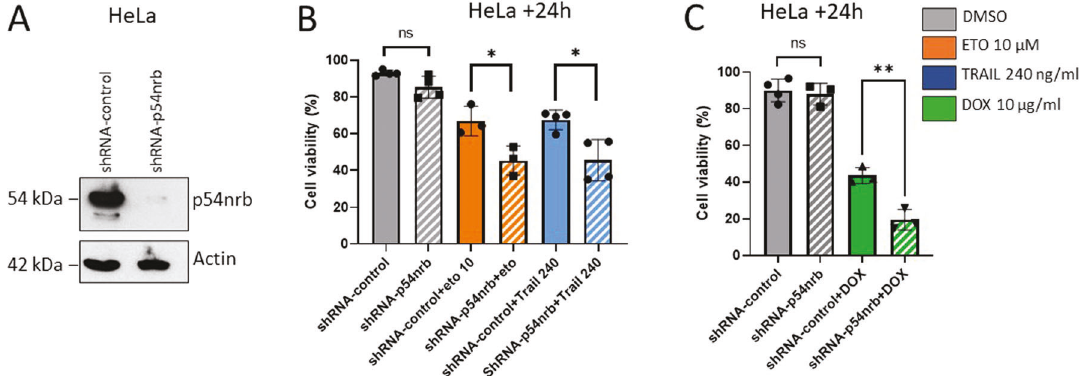
Fig. 2 Depletion of p54nrb leads to increased cell death susceptibility. A Immunoblot of p54nrb-level in shRNA-control and shRNA- p54nrb#3 knock down HeLa cells. B Flow cytometry of HeLa shRNA-control and shRNA-p54nrb#3 cells at 24 h after treatment with 10 µM etoposide (Eto) and 240 ng/ml human recombinant TRAIL (TRAIL). Cell viability was measured by detection and totaling of Annexin-V single positive and Annexin-V and propidium-iodide- double positive cells. The cells not falling to either of these categories were considered as viable cells. Signi fi cance was calculated with Student´s t test, * p < 0.05, n = 3. C Flow cytometry of HeLa shRNA-control and shRNA-p54nrb#3 cells at 24 h after treatment with 10 µg/ml Doxorubicin (DOX). Cell viability was measured by detection and totaling of Annexin-V single positive and Annexin-V and Sytox Blue- double-positive cells. The cells not falling to either of these categories were considered as viable cells. Signi fi cance was calculated with Student´s t test, ** p < 0.01, n =